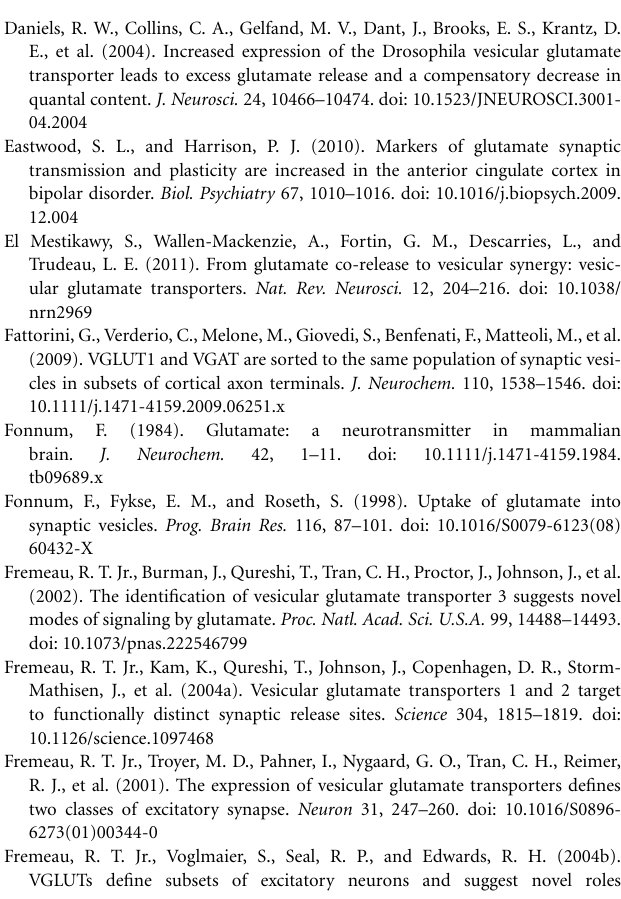
FIGURE 10 | Distribution of VGLUT1-3 mRNA and protein (immunoautoradiography [IAR] and immunohistochemistry [IHC]) in the cerebellum. Abbreviations: GcL, granular cell layer of the cerebellum; Mo, molecular layer of the cerebellum; Pc, Purkinje cell layer; Pk, Purkinje cell; wm, white mater.